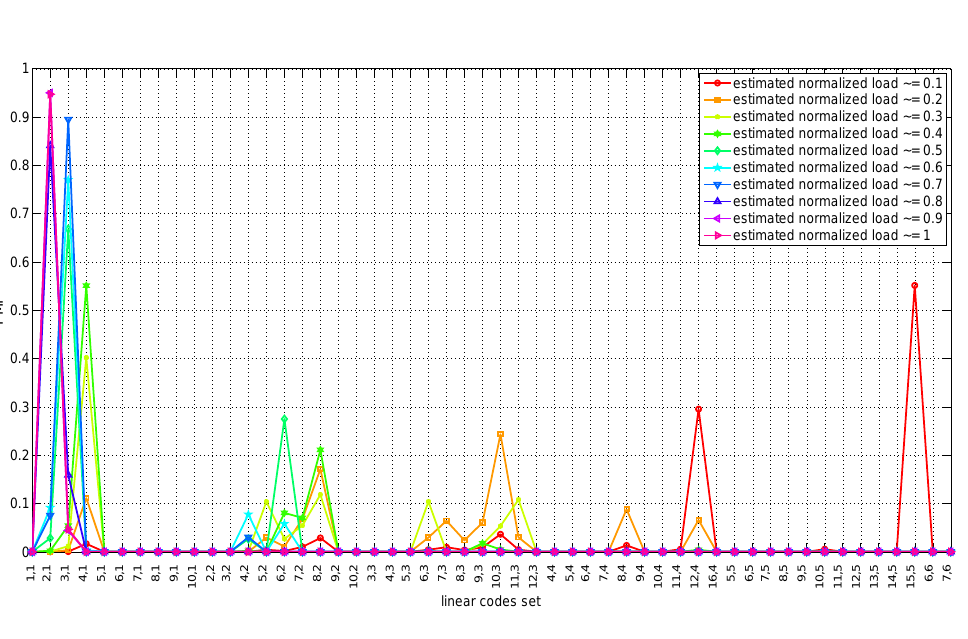
Figure 8. PMF for LC algorithm at different load levels for decreasing G , linear code set C as in table ?? .